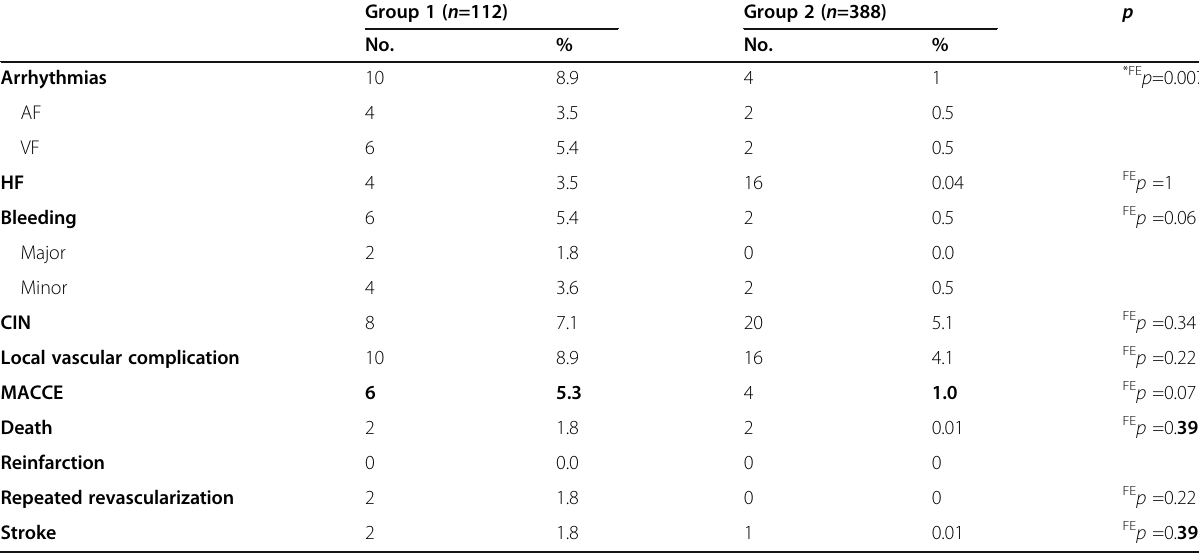
Table 5 In-hospital outcomes of the studied population